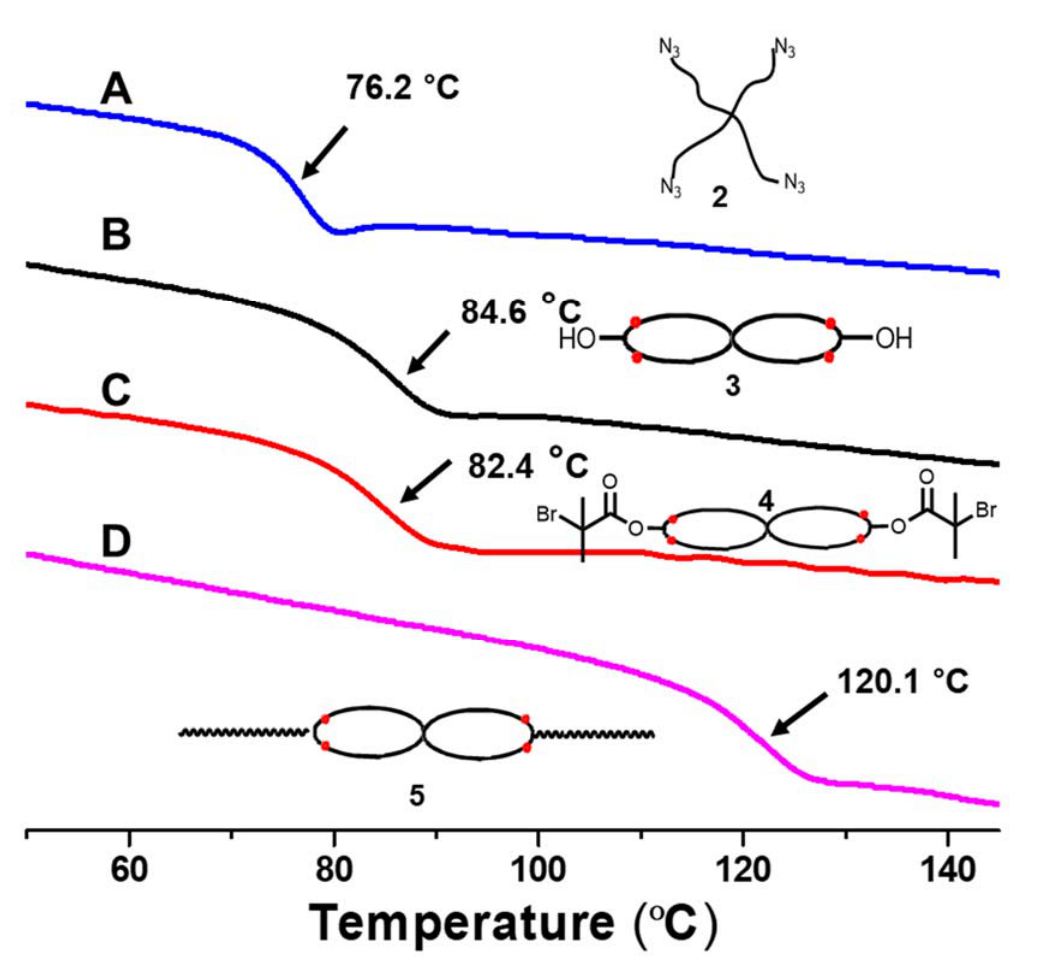
Figure 8. T g values of ( A ) tetra-arm PS-N 3 , ( B ) spirocyclic PS, ( C ) spirocyclic macroinitiator, and ( D ) PMMA- b -cPS- b -PMMA triblock copolymer.